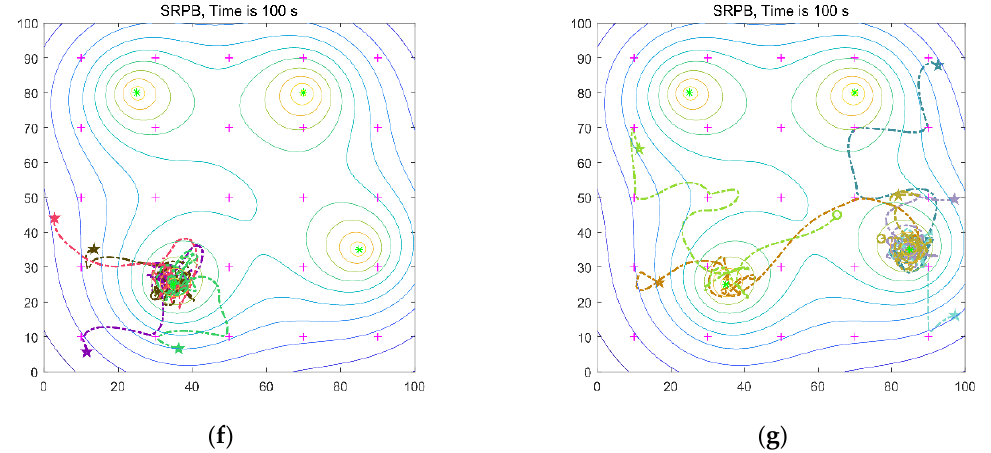
Figure 7. Twenty robots seek four isotropic signal sources. ( a ) robots’ trajectories from initial locations to the extrema; ( b ) initial location of robots; ( c ) final location; ( d ) robots move to the first target; ( e ) robots move to the second target; ( f ) robots move to the third target; ( g ) robots move to the last target. The anisotropic signals shown in Figure 1b are used. The time to find the first, the half, and the last source are 7 s, 20 s, 26 s, respectively. The collision rate is equal to 0.29, and the number of located sources is equal to 4. The robots’ trajectories are shown in Figure 8a.